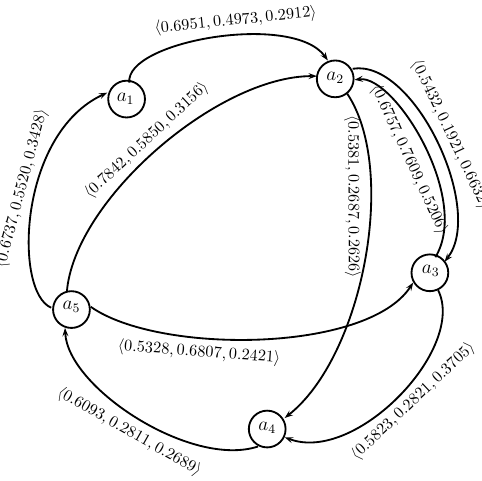
Figure 6. Partial directed network of the fused SVNPR.